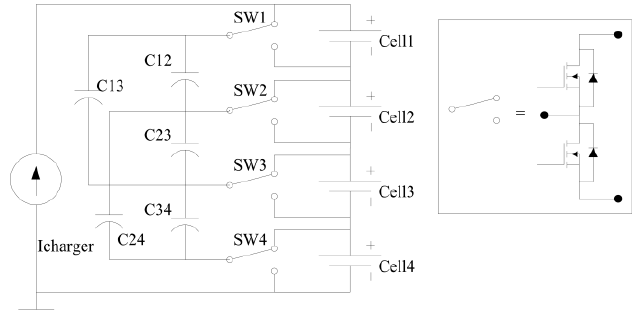
Fig. 4. Double-Tiered Switching Capacitor